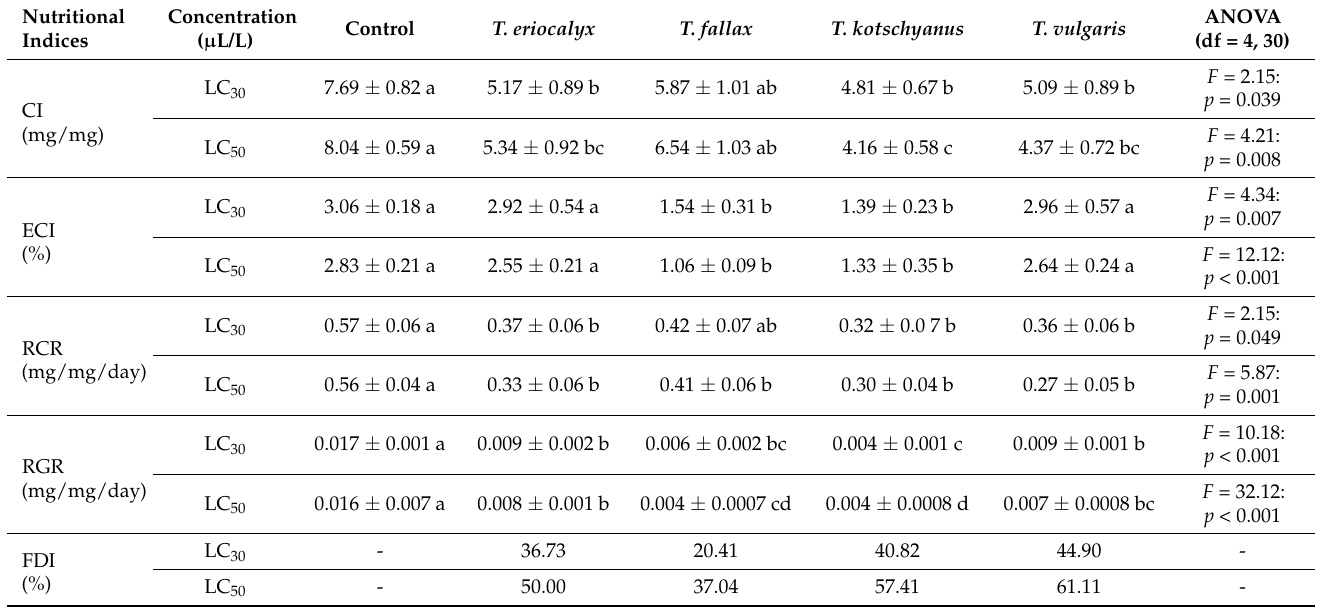
Table 6. The effects of LC 30 and LC 50 values of Thymus eriocalyx , T. fallax , T. kotschyanus , and T. vulgaris essential oils on nutritional indices (mean ± SE) of Rhyzopertha dominica